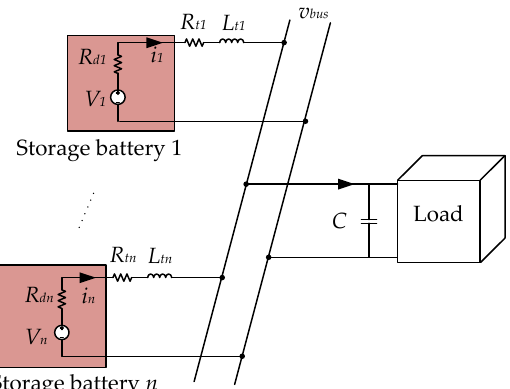
Figure 3. Multi-branch combination model of n droop control resources.